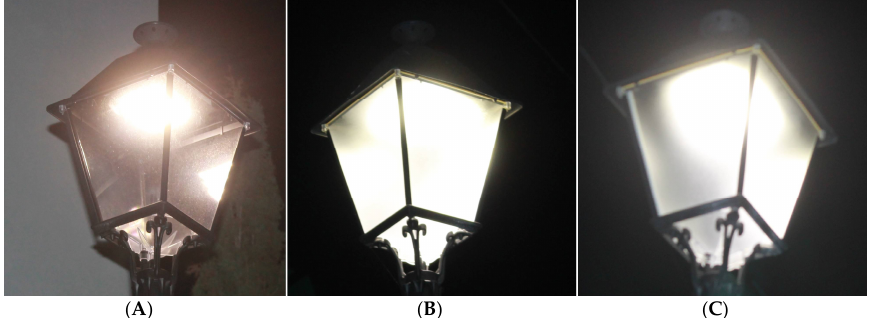
Figure 1. Villa lantern with the three covers involved in this study. Transparent ( A ) cover, high-thickness translucent ( B ) cover, and low-thickness enhanced translucent ( C ) cover.